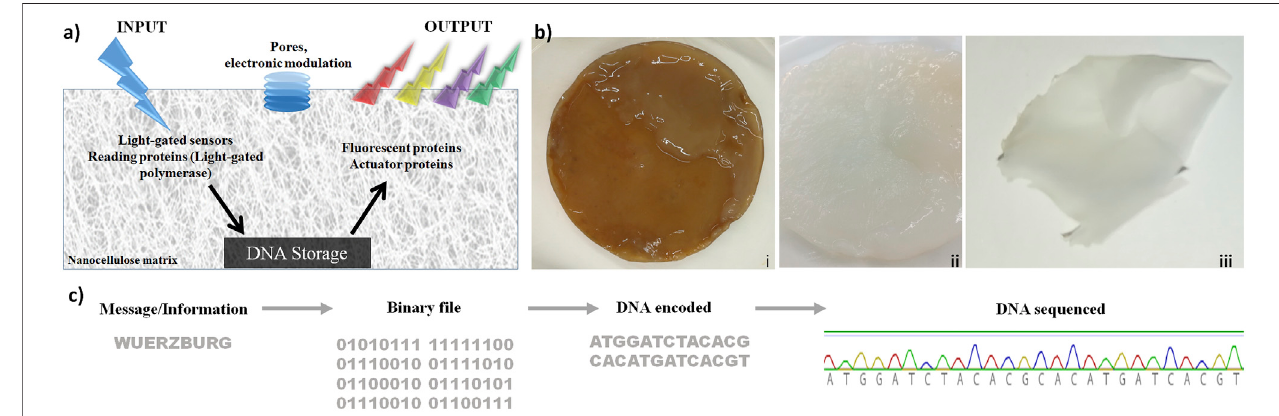
FIGURE 1 | Nanocellulose (NC) as support, chassis, and protection for DNA storage. (A) DNA chip concept: after light stimulation, proteins are activated and allowed to read the information stored on the nanocellulose. Subsequently, the actuator proteins read and analyze the processed DNA. (B) Production of bacterial nanocellulose (i) not puri fi ed bacterial nanocellulose from SCOBY (symbiotic culture of bacteria and yeast), (ii) : NC puri fi ed, and (iii) dried. (C) DNA storage on NC: the word “ Wuerzburg ” wasencoded byaneasyencodingsystem,wherethreenucleotideswereusedtoencodeoneletter. TheresultingDNAstrand wassynthesized and stored on a dried NC fi lm at room temperature. After 2 weeks, 2 months, and 2 years, the DNA was extracted from the NC and